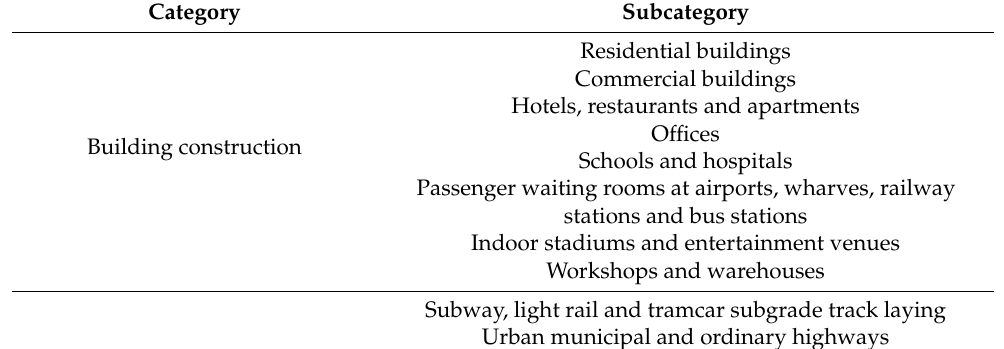
Table 1. Scope of building and civil